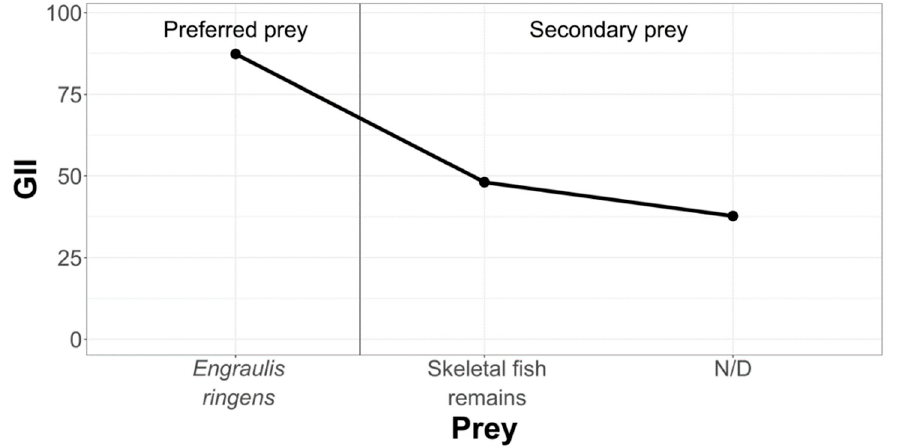
Figure 7. Hierarchization and classification of prey in the La Capilla study area, according to the Geometric Importance Index.